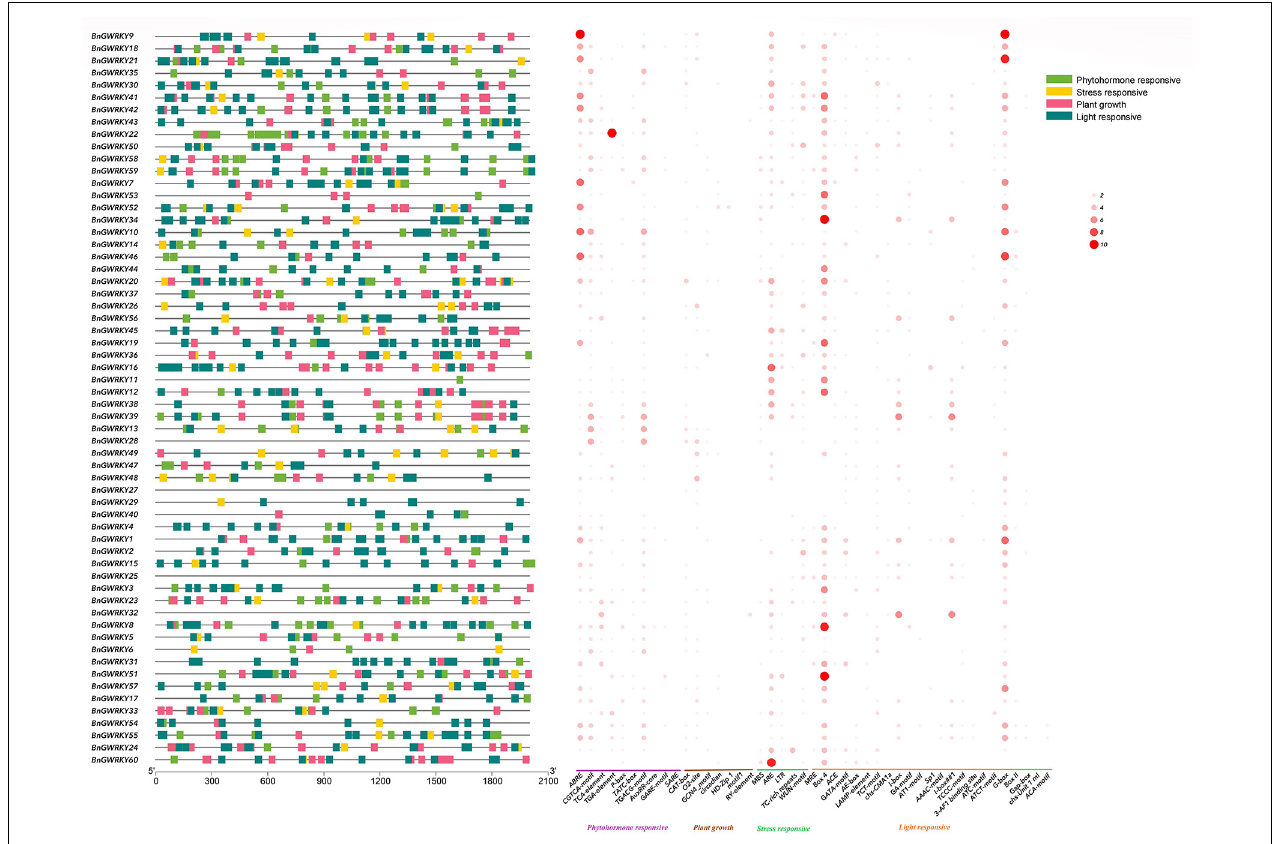
FIGURE 6 | Analysis of the cis -elements in the promoter region of the BnGWRKY genes. The left figure shows the distribution of the upstream promoter regions (2,000 bp) of the four cis -acting elements. The heat map of cis-elements for phytohormone response, stress response, plant growth, light response is shown on the right, with the size of the circles indicating the number of cis